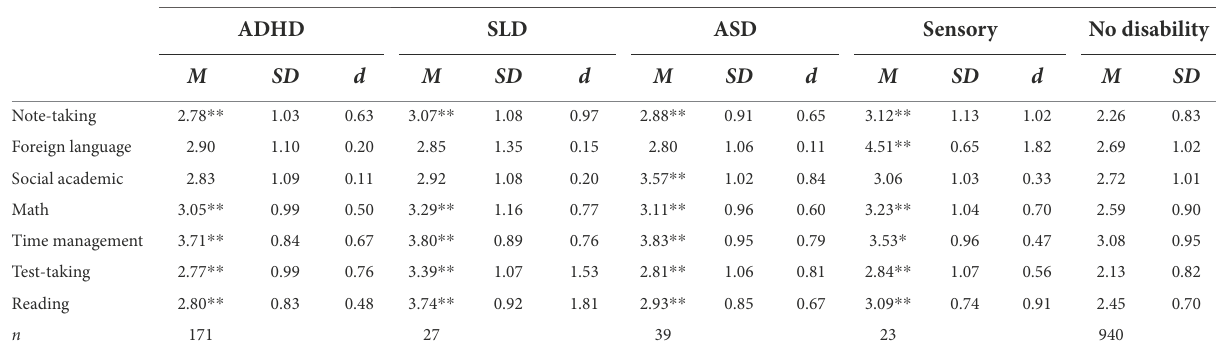
TABLE 5 Average AIM composite scores as a function of disability history.